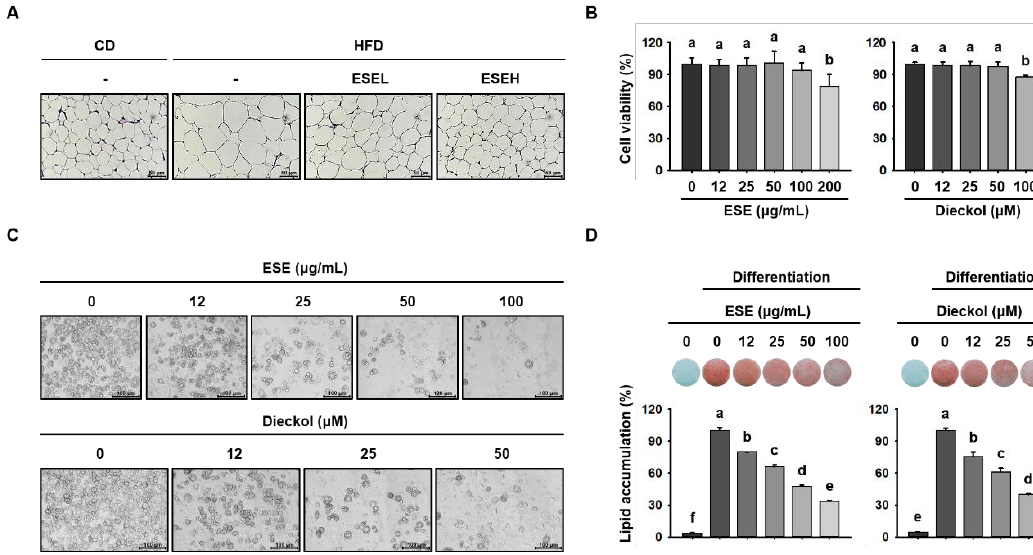
Figure 2. Effects of ESE on adipocyte size and lipid accumulation in HFD-fed mice and 3T3-L1 adipocytes. ( A ) WAT sections stained with hematoxylin and eosin (H&E). Scale bar: 50 μm. ( B ) Viability of 3T3-L1 adipocytes treated with ESE or dieckol for 24 h. ( C ) Microscopic images of 3T3-L1 adipocytes after 8 days of differentiation. Scale bar: 100 μm. ( D ) Oil red O (ORO) staining of 3T3-L1 cells treated with ESE or dieckol after 8 days of differentiation. Data are expressed as means ± SDs ( n = 4). Values with different letters are significantly different: p < 0.05 (a > b > c > d > e > f). ND, non- differentiation.